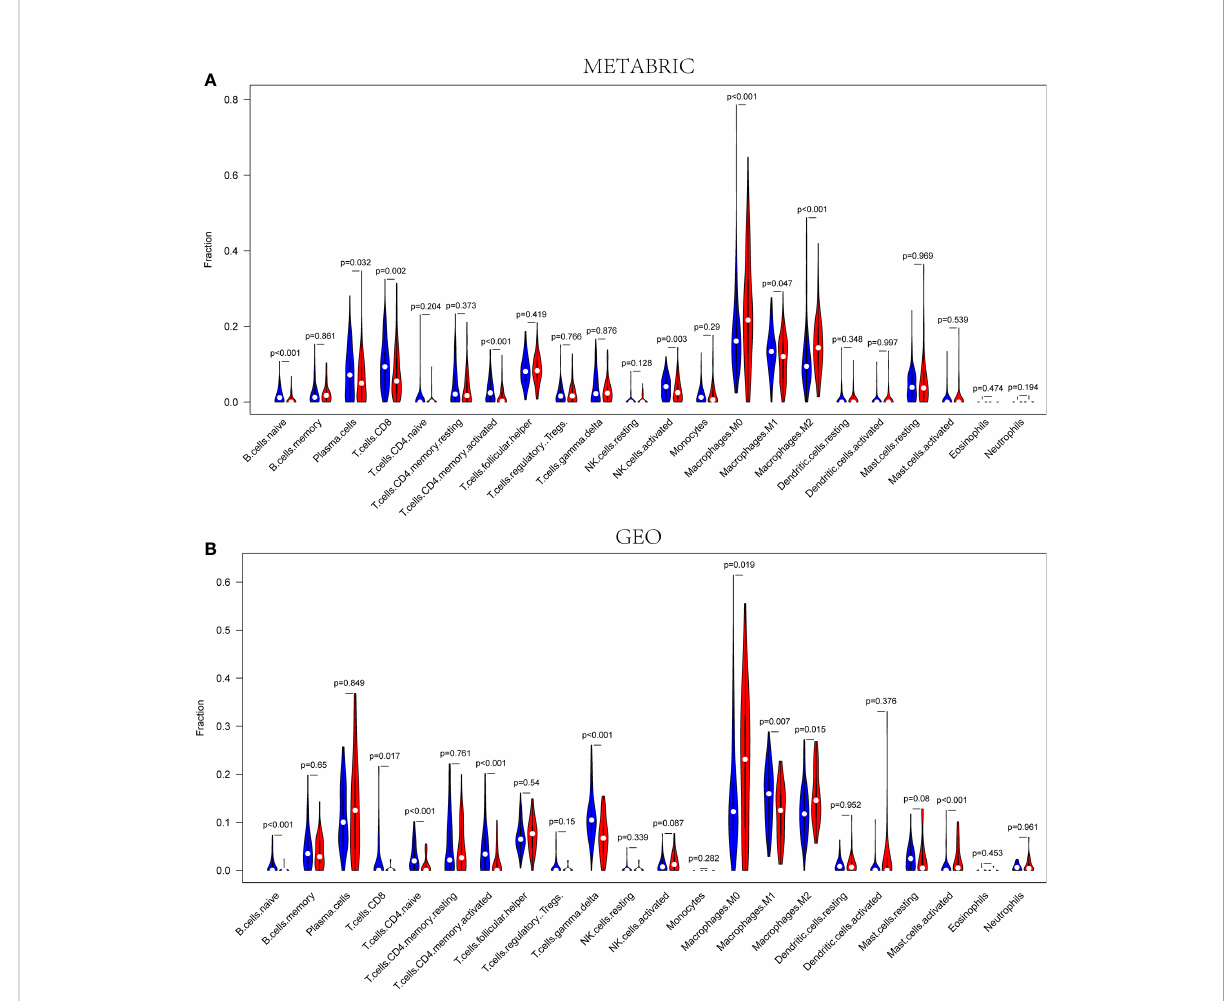
FIGURE 7 The in fi ltration fractions of different immune cells between the high- and low-risk groups in the METABRIC (A) and GEO (B) sets, respectively. Red represents high-risk groups, and blue represents the low-risk group (P<